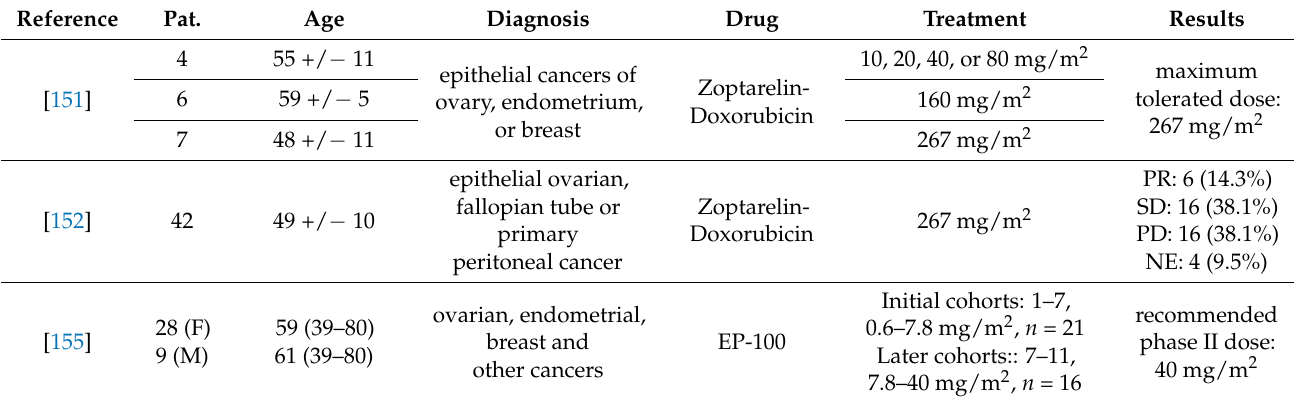
Table 2. Clinical trials—GnRH receptor target therapy for treatment of epithelial ovarian